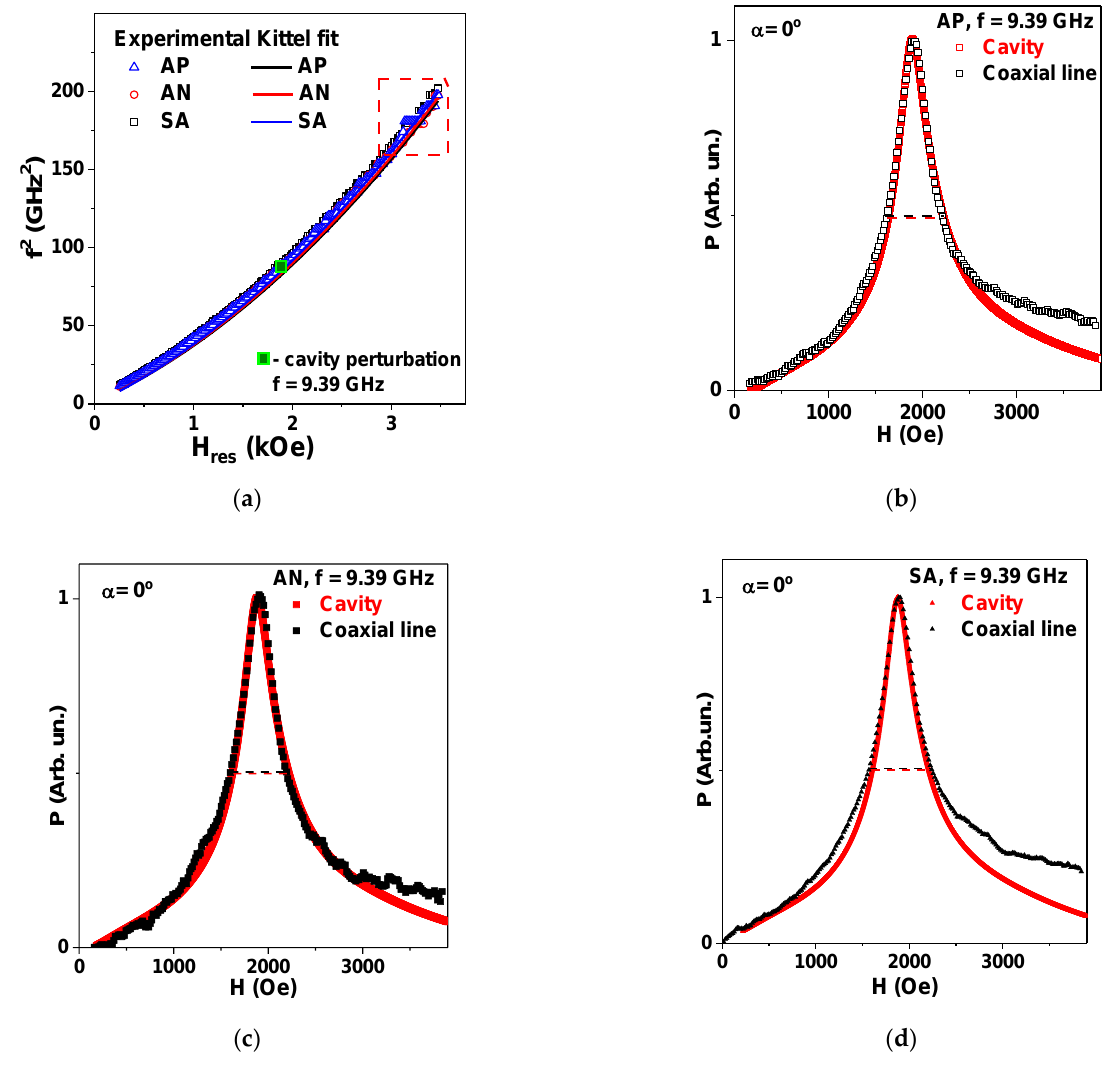
Figure 9. Microwave absorption measurements using a complete coaxial waveguide for Fe 3 Co 67 Cr 3 Si 15 B 12 amorphous ribbons in different states AP, AN and SA. Experimental results and Kittel´s fit. ( a ) Dashed rectangle indicates the frequency range where the measurements are still possible but less precise as the approximation to the 50 Ohm matching waveguide characteristic impedance (Z 0 ) deviates. ( b – d ) Direct comparison of the FMR resonance lines obtained for the frequency f = 9.39 GHz both by the cavity perturbation technique and using the coaxial waveguide for all ribbon types . Red and black dashed lines indicate the width of the FMR resonances.